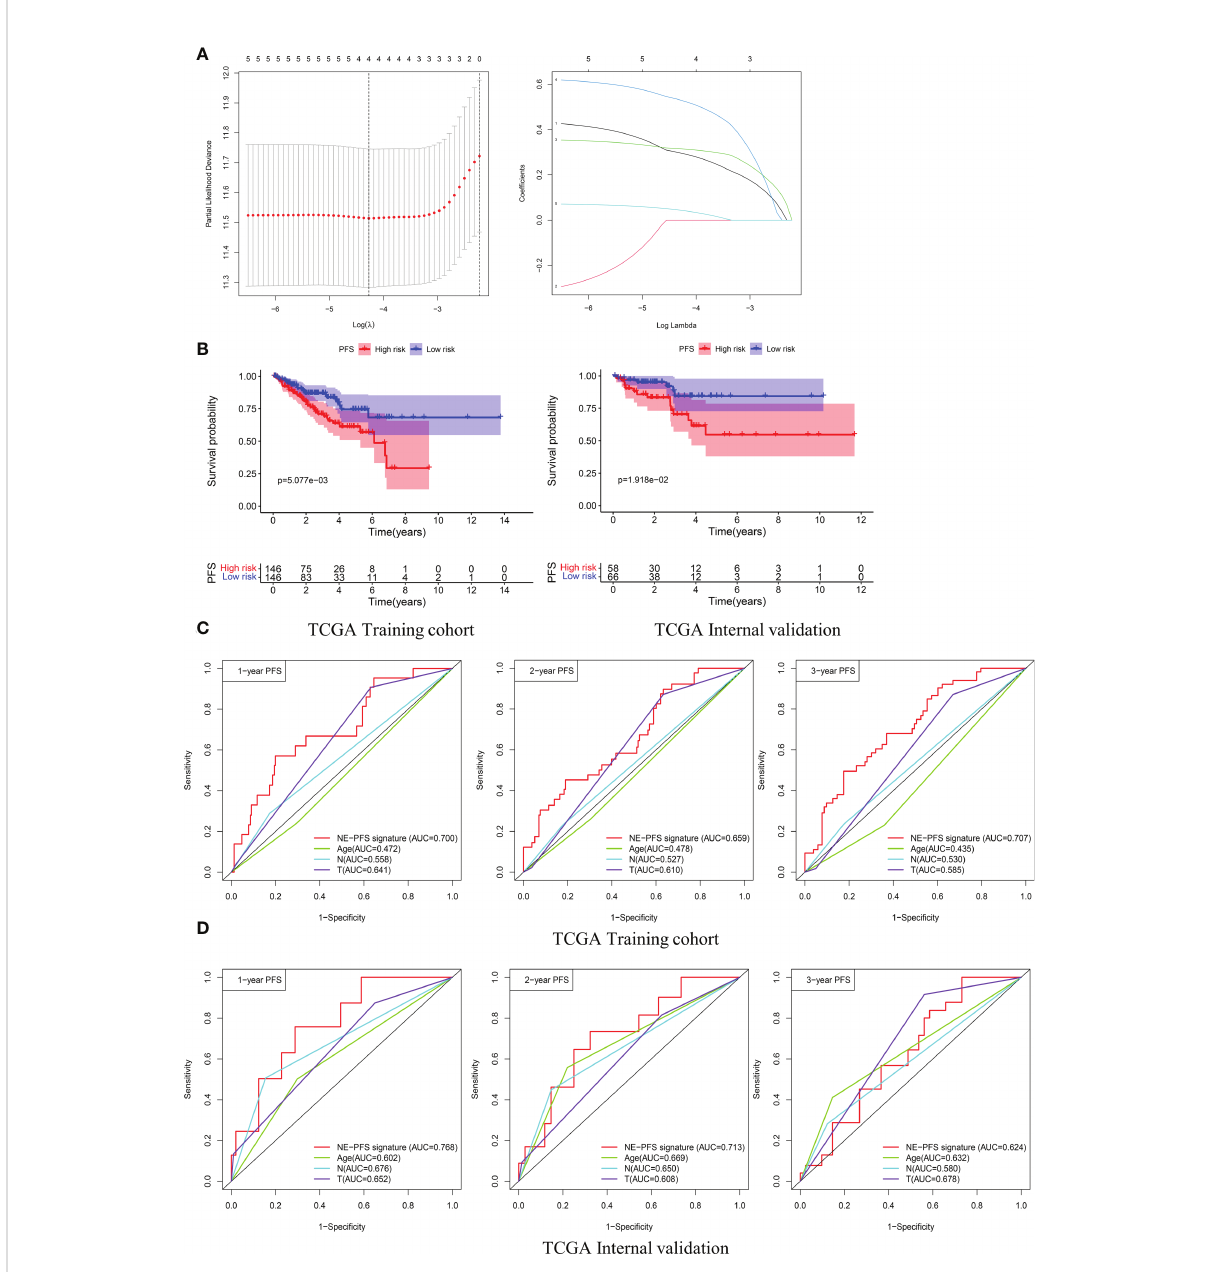
FIGURE 10 Construction and validation of the prognosis model for PFS in the TCGA PanCancer cohort. (A) Four genes correlated with PFS were selected for multivariate analysis by LASSO regression analysis. (B) Kaplan-Meier plots evaluate the predictive ability of the constructed prognostic model in the TCGA PanCancer training cohort and internal validation cohort, respectively. (C, D) NE-PFS signature exhibited better predictive ability than other clinical features as displayed, the 1-, 2- and 3- year AUC for PFS was 0.700 (95% CI: 0.587 − 0.814), 0.659 (95% CI: 0.566 − 0.752), and 0.707 (95% CI: 0.622 − 0.792) in the TCGA PanCancer training